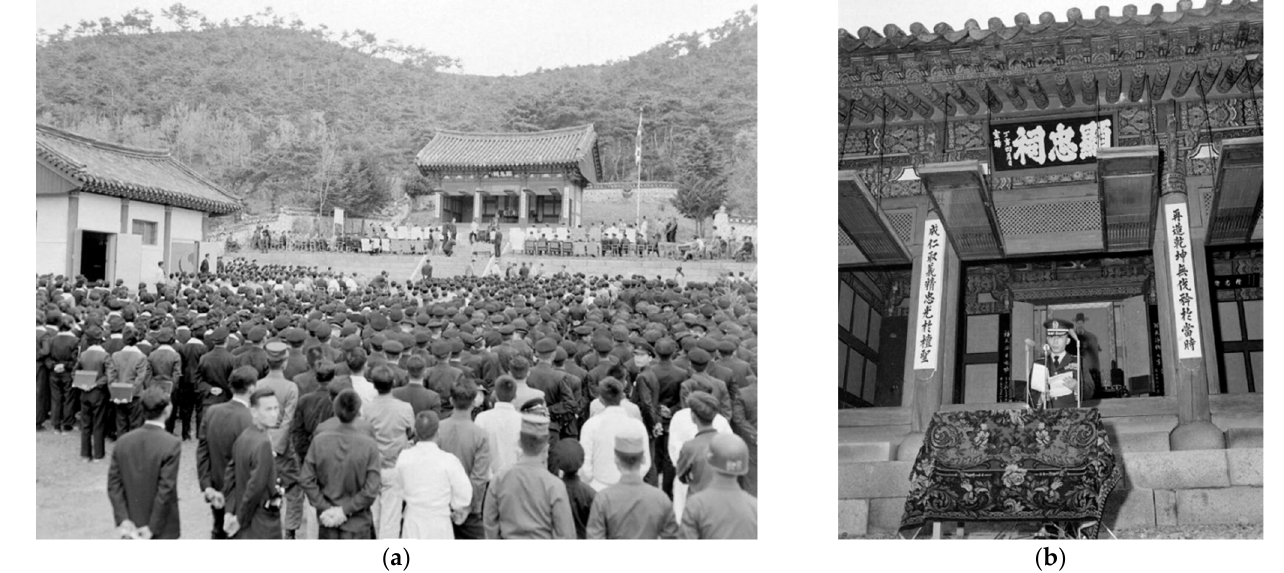
Figure 6. ( a ) Ritual Ceremony for Admiral Yi’s birthday in 1963. ( b ) Acting President Park delivering a commemorative speech for the event in front of the shrine built in 1932. (Source: National Archives of Korea).